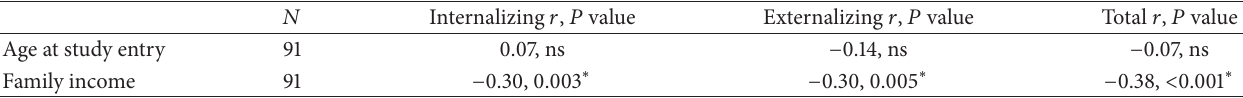
Table 7: Correlations between psychological adjustment and age at study entry and family income in study subjects.